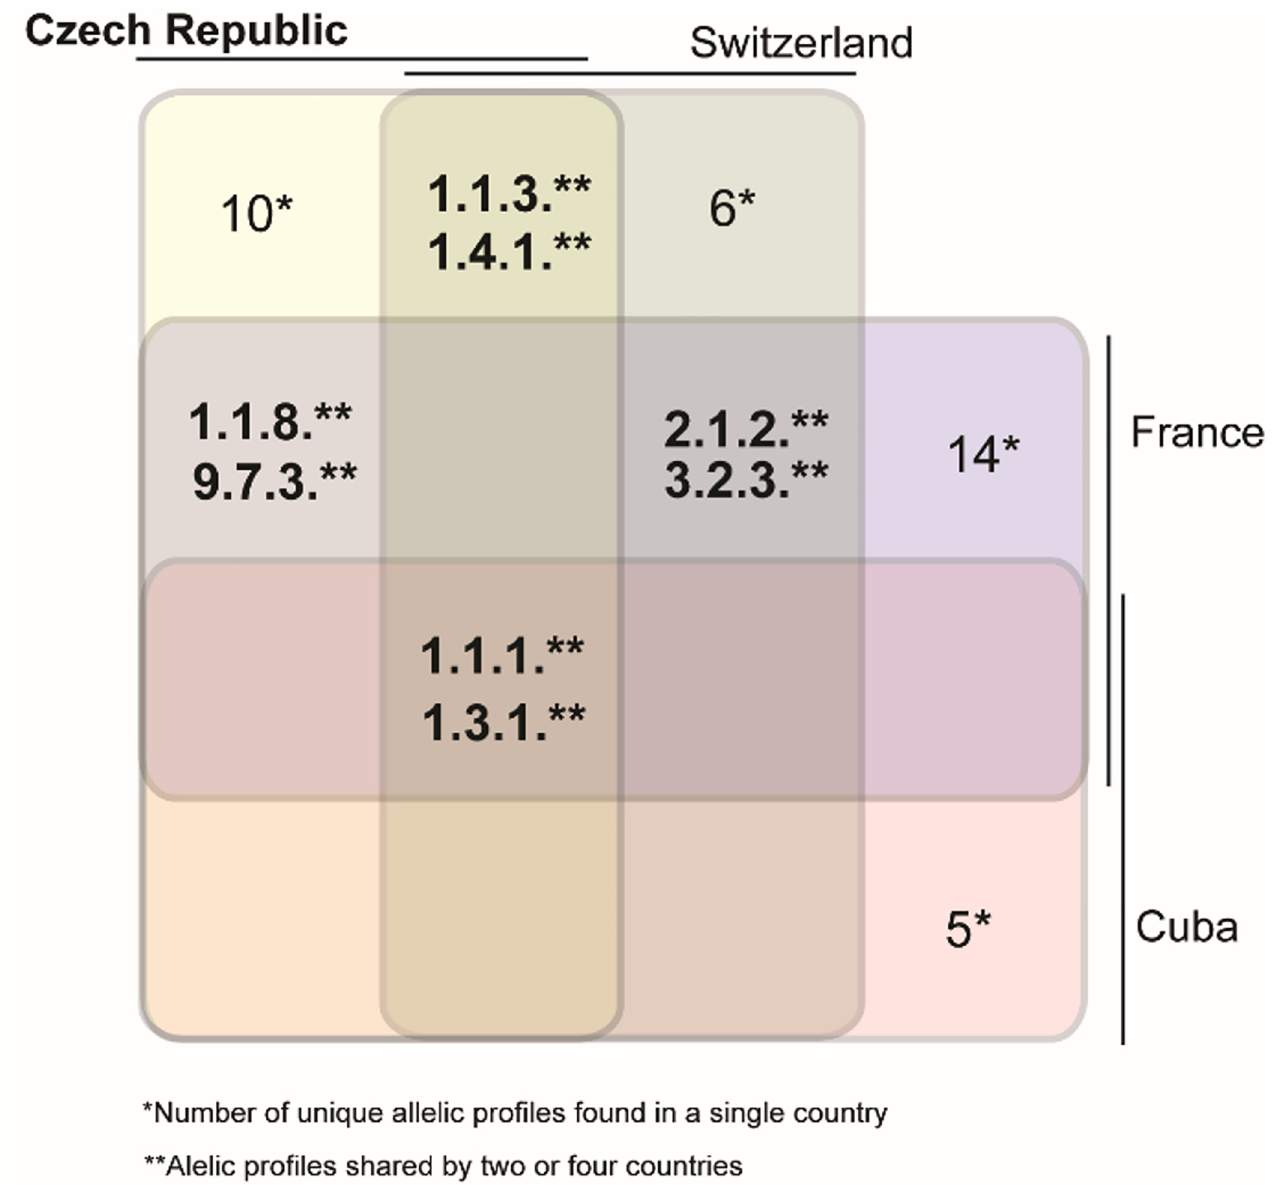
Fig 5. TPA allelic profiles identified in the Czech Republic, France, Switzerland and Cuba [15–18].